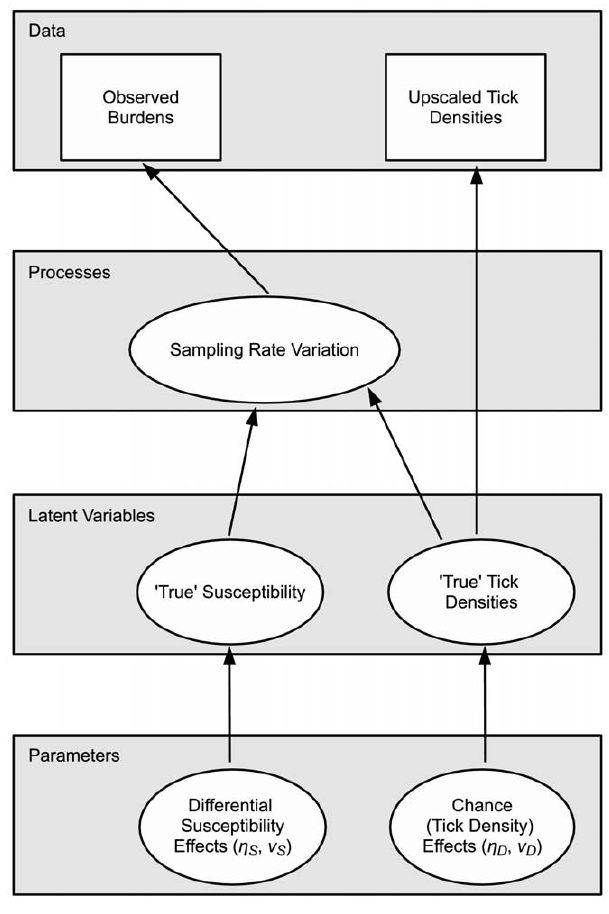
Figure 1. Hierarchical Bayesian model structure of the tick accumulation model. Gray boxes identify the levels in the hierarchy, white boxes represent data, and white ovals represent low-level model elements. Arrows show the relationships among model elements.